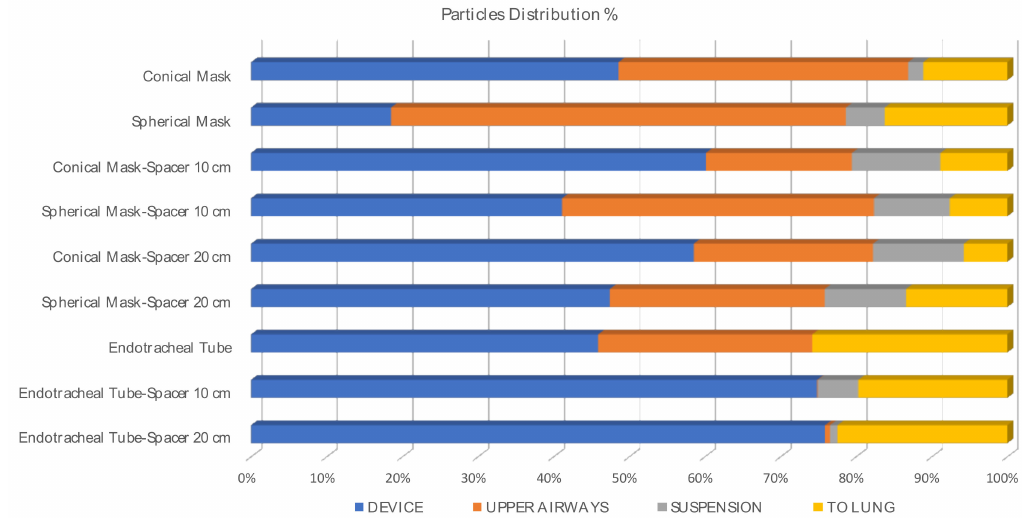
Figure 6. Percentage of particle distribution after 7 respiratory cycles (I:E ratio 1:2, inspiratory time 1 s) into the three regions (device, upper airways, to the lung), as well as remaining in